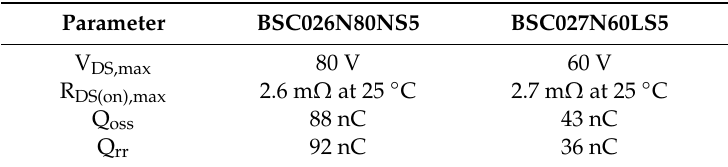
Table 2. Si LV Table 2. Si LV MOSFETs.